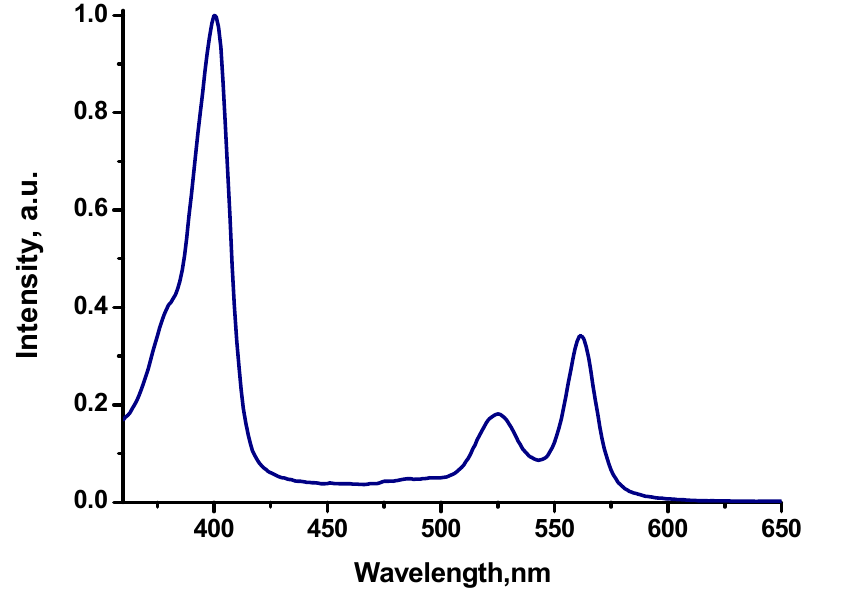
Figure 4. Photoluminescence excitation spectrum of Cu-EtioP in polystyrene film at 25 °C. Table 1. Photophysical data for copper(II) porphyrinates measured in polystyrene film.